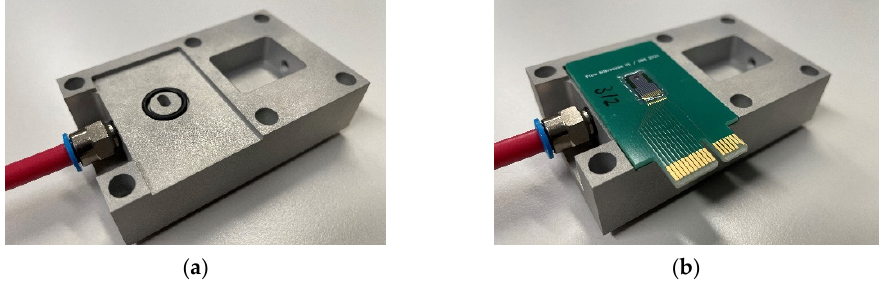
Figure 7. Custom vacuum chuck without ( a ) and with ( b ) mounted PCB. By connecting the pink tubing to a turbopump, a vacuum can be created inside the porous PowderMEMS structure located beneath the thin-film membrane.